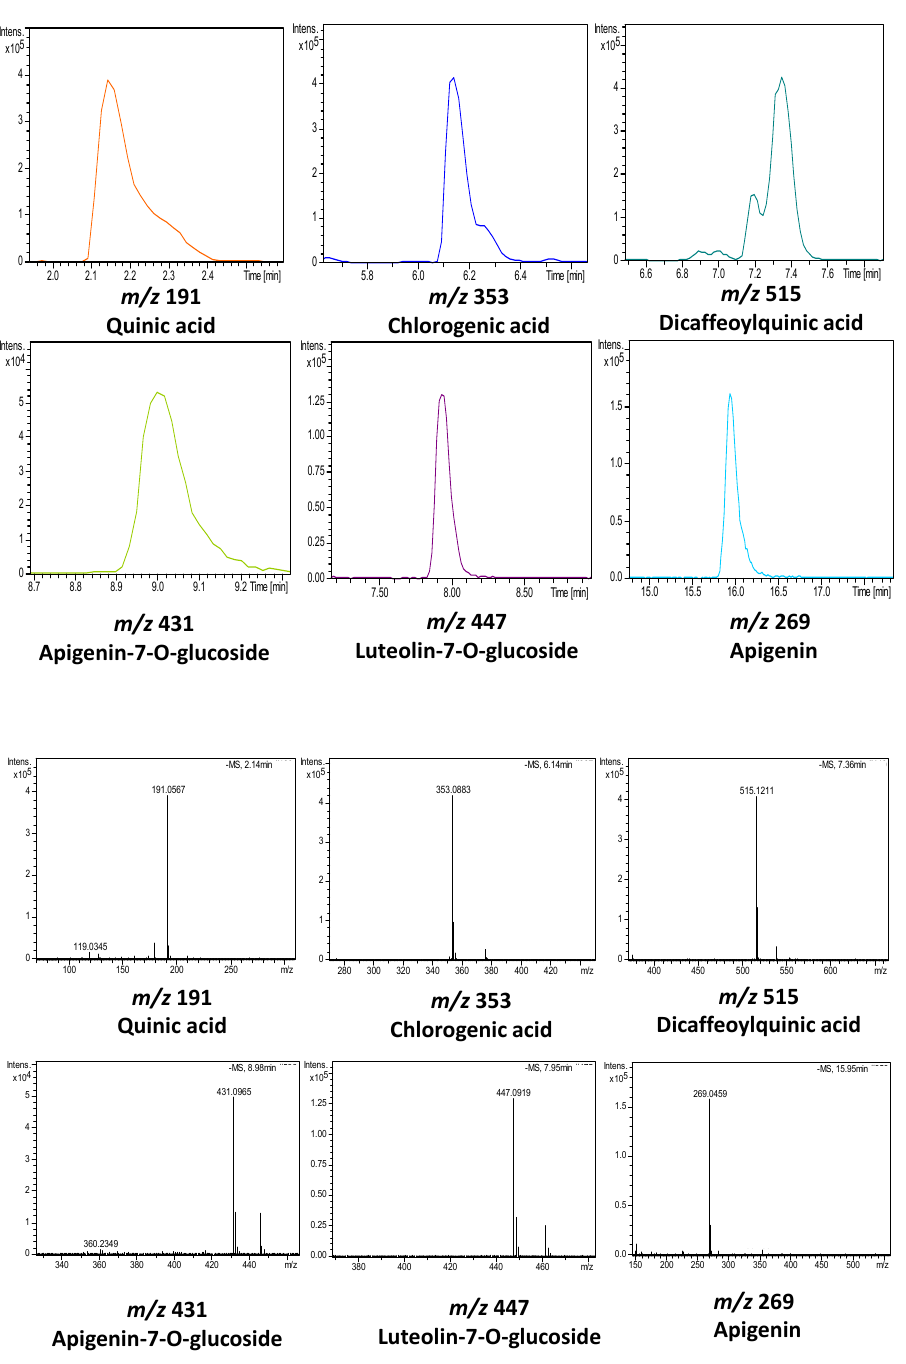
Figure 2. Extracted ion chromatograms (EIC) and mass spectra of some phenolic compounds characterized by HPLC-time-of-flight mass spectrometry with an electrospray interface (ESI-TOF/MS) in artichoke by-products. Table 2. Phenolic and other polar compounds characterized in Cynara scolymus L. PLE extracts analyzed by HPLC-time-of-flight mass spectrometry with an electrospray interface (ESI-TOF/MS).